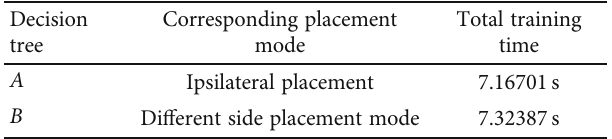
Table 9: Decision tree training schedule.